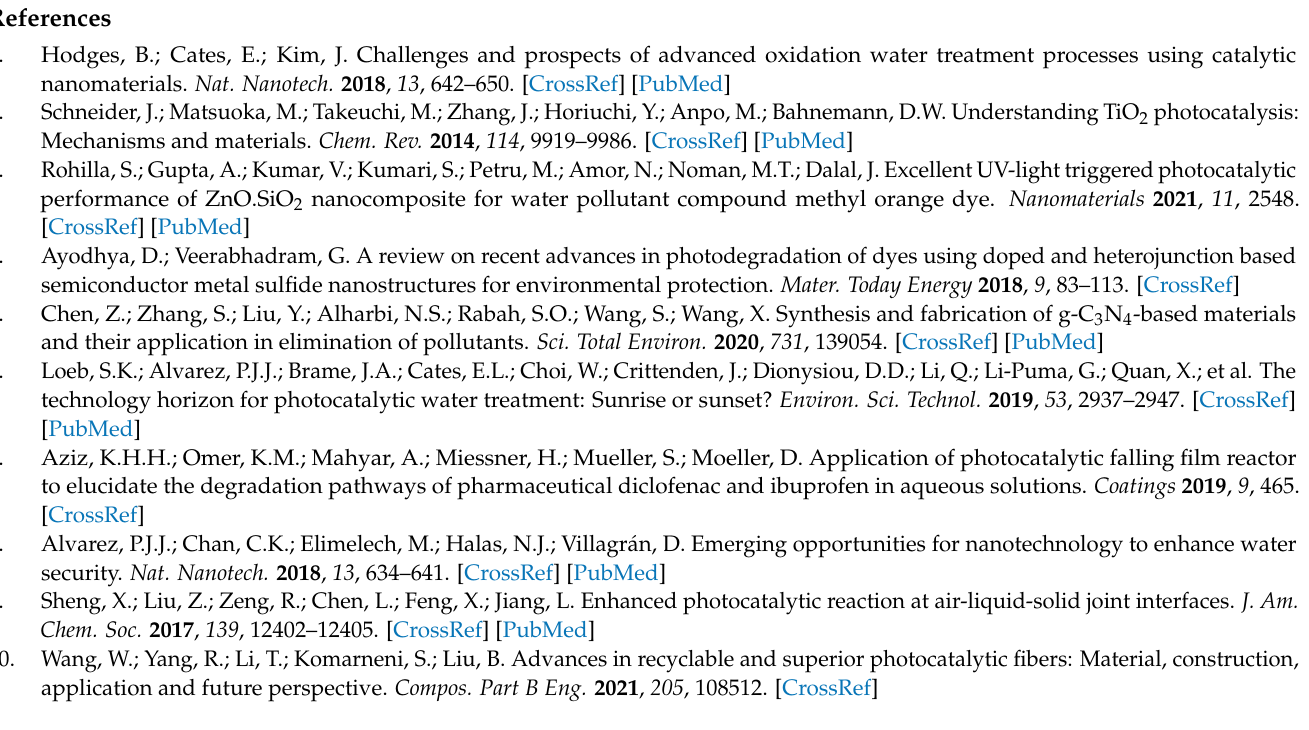
Figure S3. (a) Photo and (b,c) corresponding SEM images of the bonded photocatalytic membrane (BPM), Figure S4. (a–c) Photocatalytic MO degradation processes of the FPM; and (d) Photocatalytic MO degradation results after 72 h, Figure S5. Photos of the commercially available TiO2 photocatalytic membranes: (a) sweater-type membrane (C1), and (b) paper-type membrane (C2), Figure S6. Photo of domestic sewage source (Quanzhou, Fujian Province, China), Figure S7. SEM images of the (a) pure PU membrane, (b) PET substrate (fiber fabric), and (c) the artificially cracked FPM, showing PET fiber substrate supported P25+PU membrane, Figure S8. Photo of powder separated from the BPM in water, Figure S9. (a–c) Photos of photocatalytic processes of the FPM in summer (28 July~4 August., 2021), Figure S10. SEM images of the photocatalytic membranes (a,b) the FPM (c,d) the BPM after domestic sewage treatment, Table S1. Photocatalytic performance of the FPM for outdoor sewage treatment in